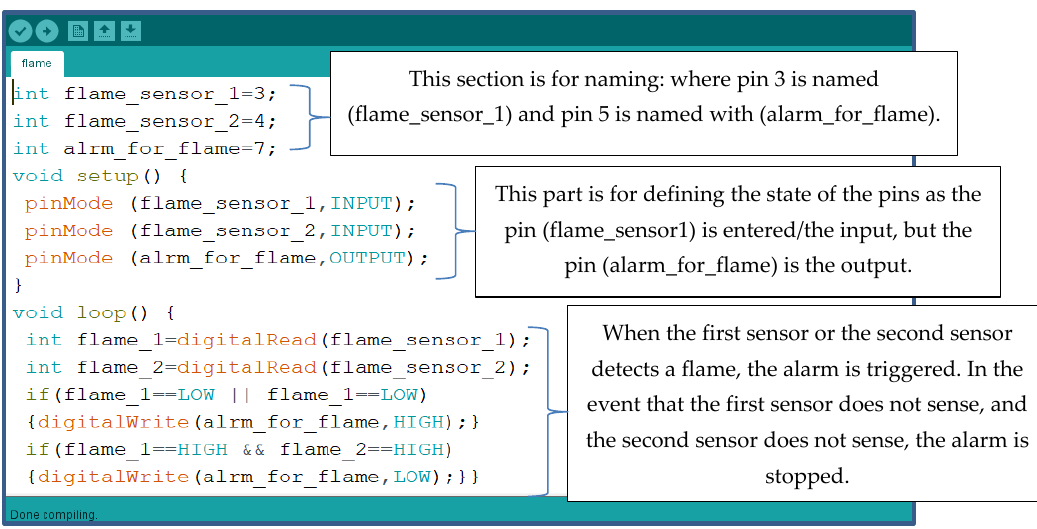
Figure A6. The second part of the executed code used to program the heat and humidity sensor.